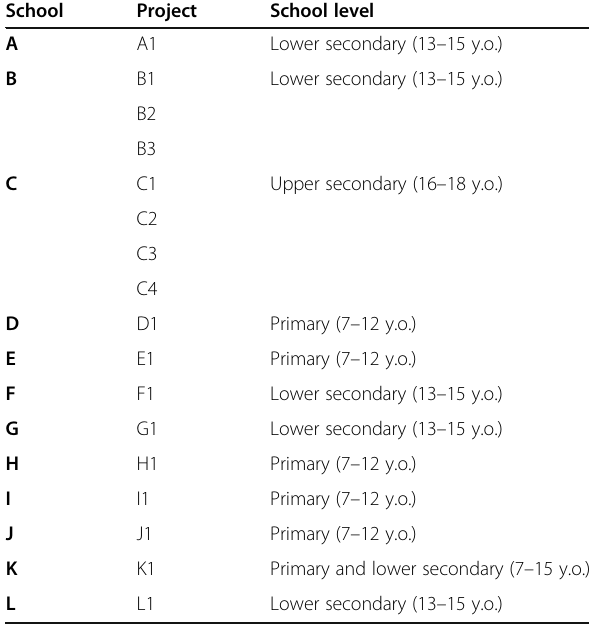
Table 5 Distribution of data across school levels. Schools that provided multiple projects: named with subsequent numbers School